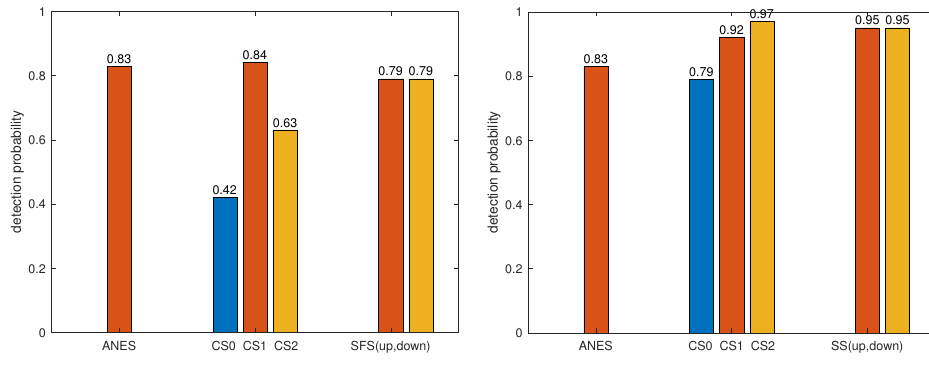
( b ) The radar with ANES and the jammer with ele- mentary strategies